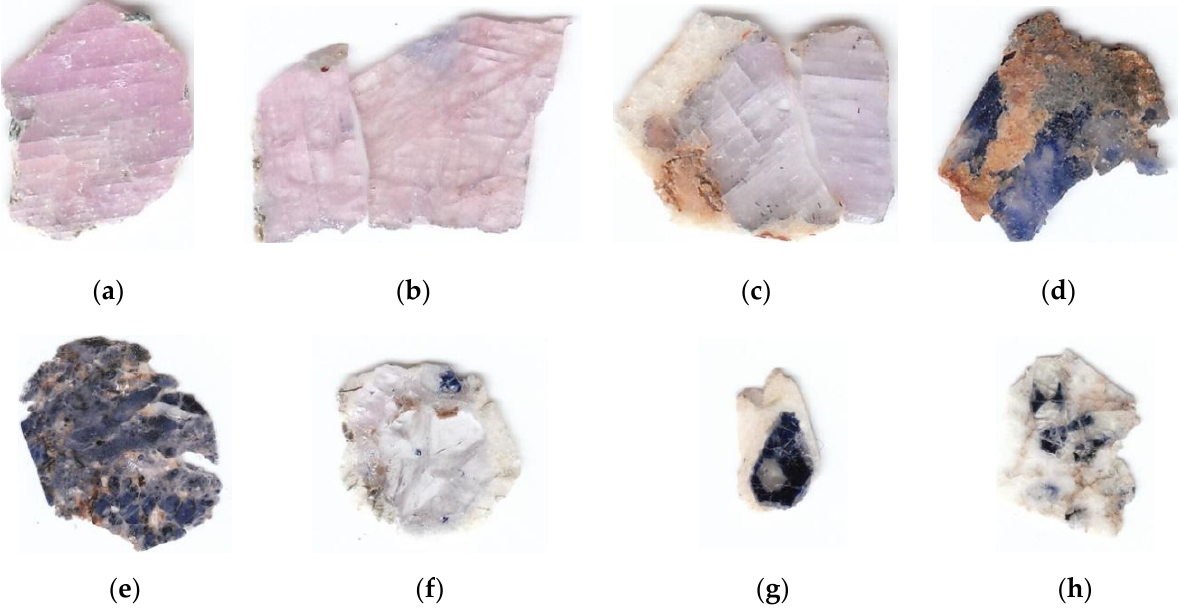
Figure 2. Photographs of the eight studied corundum samples from Greece. ( a , b ) Transparent to translucent pink sapphires hosted in amphibole schist from Paranesti in Drama (samples DR1a-a; slightly red, sized 8 cm × 7 cm × 0.6 cm and PARa-b, broken in two pieces, total size 12 cm × 10 cm × 0.5 cm); ( c ) transparent to translucent pink (slightly purple) sapphire hosted in marble from Gorgona in Xanthi (sample GO5a broken in two pieces) total size 10 cm × 7.5 cm × 0.6 cm; ( d ) transparent to translucent sapphire hosted in marble from Gorgona in Xanthi (sample GORa) sized 11 cm × 8 cm × 0.4 cm; ( e ) transparent to translucent light blue to blue sapphire hosted in meta-bauxite from Ikaria island (sample IK1b sample) sized 16 cm × 2.5 cm × 0.2 cm; ( f – h ) transparent to translucent colorless to blue sapphires hosted in plumasite from Kinidaros, Naxos island (samples NX1a-f, sized 9.5 cm × 8 cm × 0.5 cm, NX2a-g, sized 7.5 cm × 4 cm × 0.6 cm and NX4a-h, sized 10 cm × 4 cm × 0.5 cm).